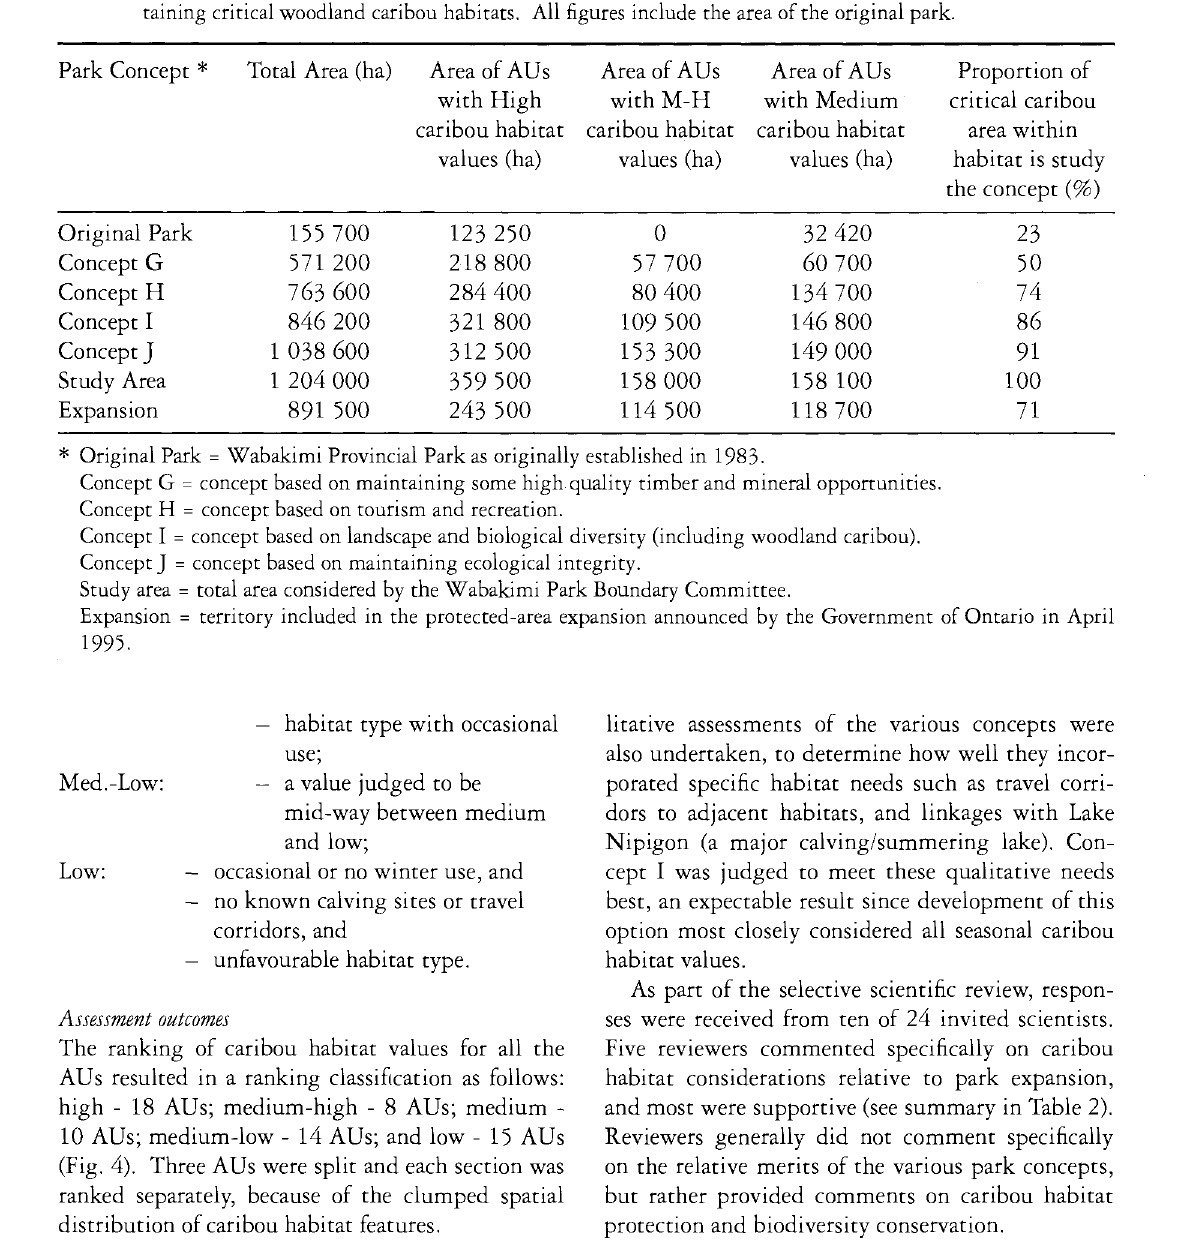
Table 1 . Relative ability of four park concepts (G to J) and the proposed expansion to incorporate assessment units con taining critical woodland caribou habitats. All figures include the area of the original